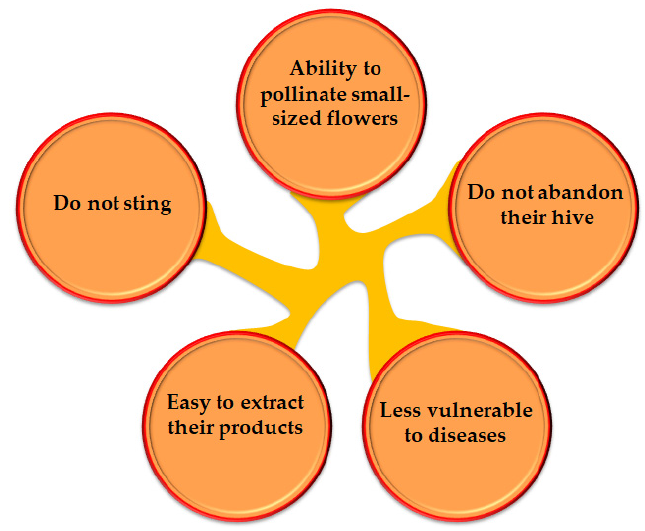
Figure 1. Principal characteristics of stingless bees that differentiate them from honeybees [7].